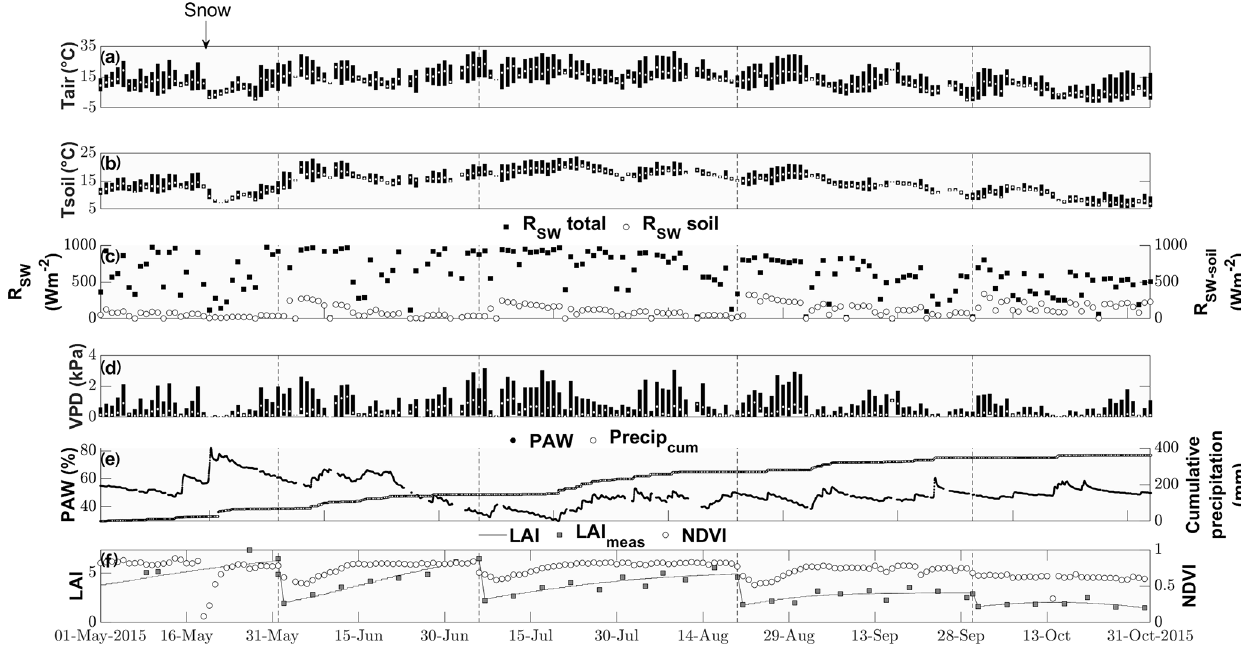
Figure 1. Seasonal cycle of ancillary variables. Daily minimum, maximum and median (a) air and (b) soil temperatures ( ◦ C) indicated by the lower and upper end of the bars and the white circle, respectively. (c) Daily maximum incident shortwave radiation (Wm − 2 ) reaching the top of the canopy (black squares) and reaching the soil surface (white circles). (d) Daily minimum, maximum and median vapor pressure deficit (kPA) indicated by the lower and upper end of the bars and the white circle, respectively. (e) Plant-available water (%) depicted by black squares and cumulative precipitation (mm) depicted by open circles. (f) Modeled leaf area index (black lines), measured LAI (gray squares) and normalized difference vegetation index (open circles).